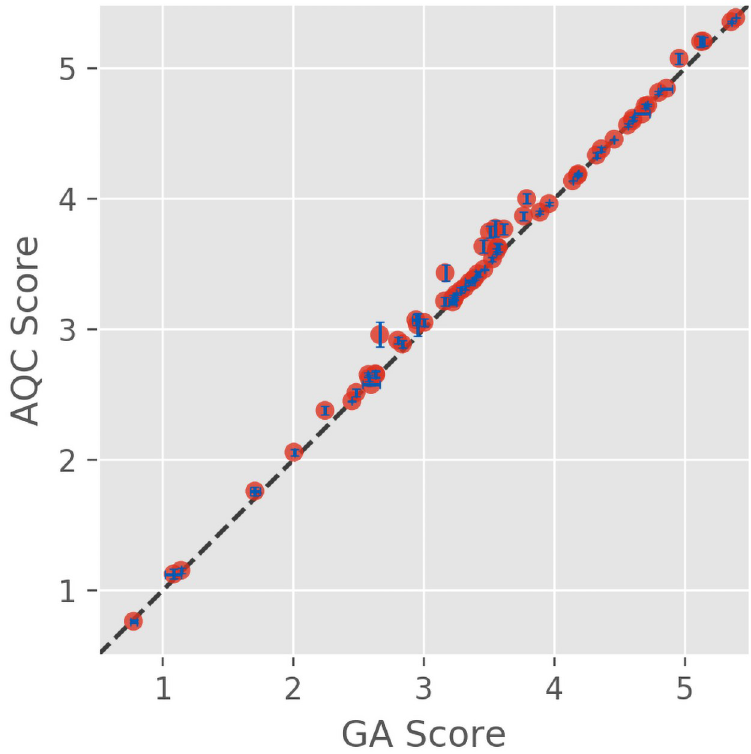
Fig 2. Eigenvalues measured by QA vs GA scores. Lower scores indicate higher probability of expression. Dashed line represents y = x. Error bars represent the standard deviation of 20 trials and are shown in blue.